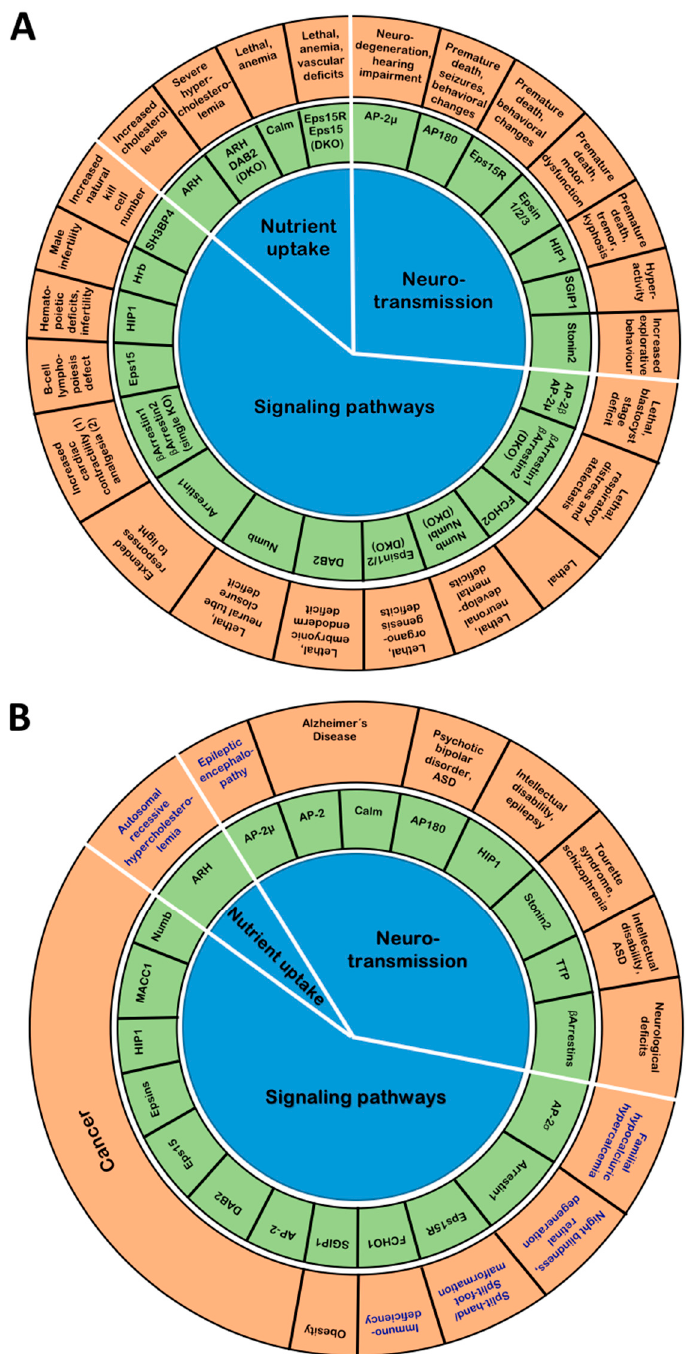
Figure 3. Endocytic adaptors, KO mouse phenotypes and human diseases. ( A ) Illustration of phenotypes due to deletion of endocytic adaptors in mice. ( B ) Illustration of human diseases associated with endocytic adaptors. Diseases caused by specific mutations in endocytic adaptors are highlighted in blue.